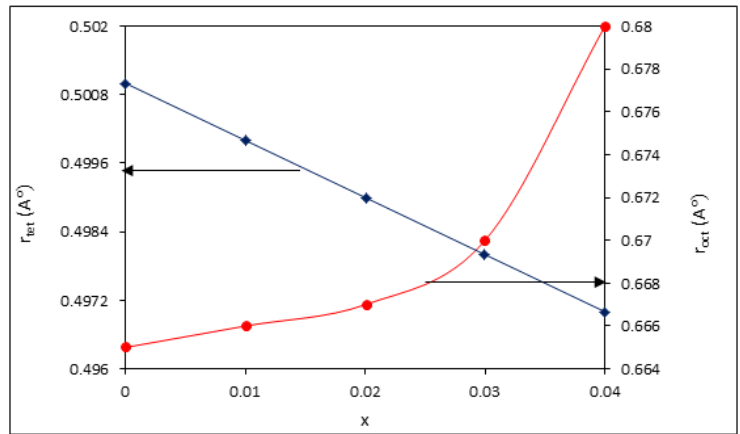
Fig. 4: Variation of tetrahedral and octahedral radius with lithium ions (x) concentration.